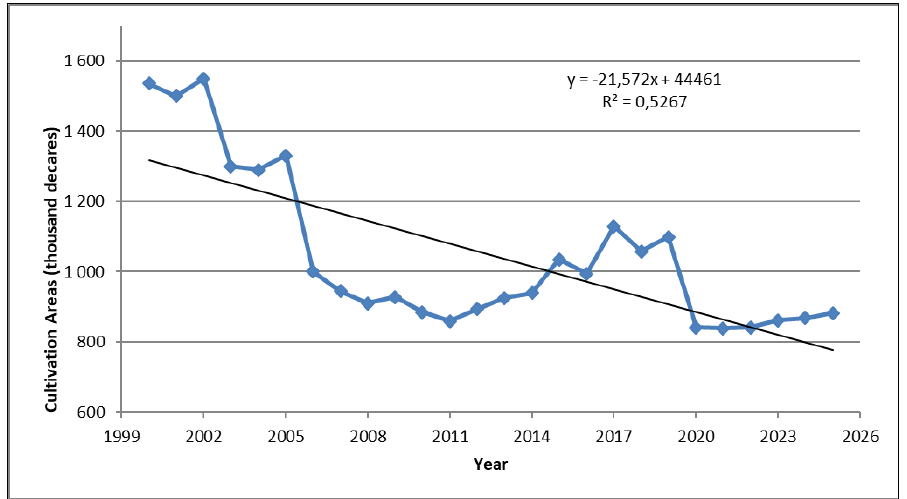
Figure 4: Oat cultivation area in Turkey (2000-2025).